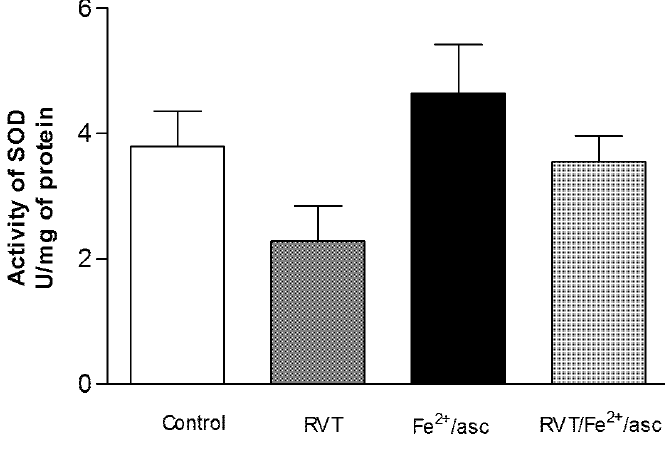
Figure 4. Effect of RVT on SOD activity. Spermatozoa were obtained from ductus deferens in M-16 medium, pooled and incubated with RVT, Fe 2+ /asc or RVT + Fe 2+ /asc. Enzymatic activity of SOD was measured with a spectrophotometer after using the RANSOD assay kit. Values represent the mean ± SD of three independent experiments performed in duplicate. No significant differences were